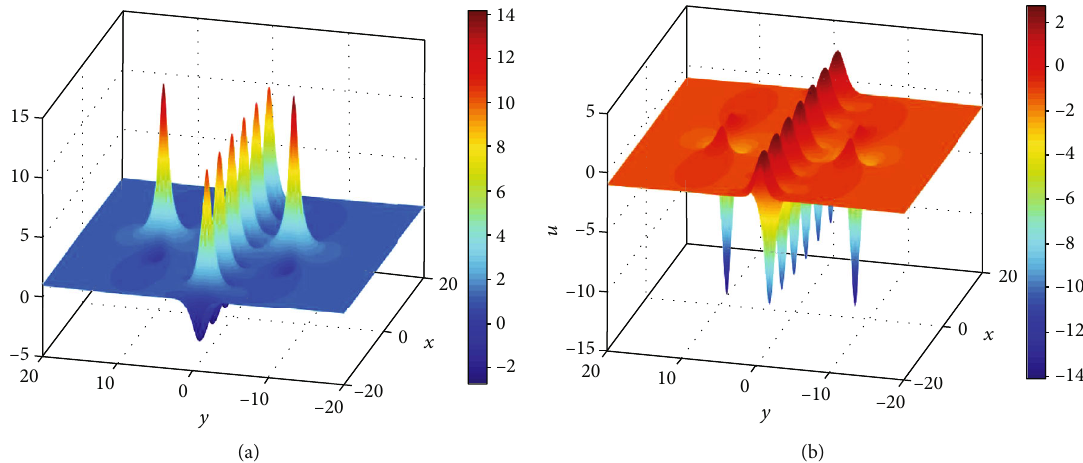
Figure 8: Two types of interactions between a lump and two breathers in Equation (1) at t = 0 . (a) Bright-type interaction solution with u 0 = 1 and c = − 1 . (b) Dark-type interaction solution with u 0 = − 1 and c = 1